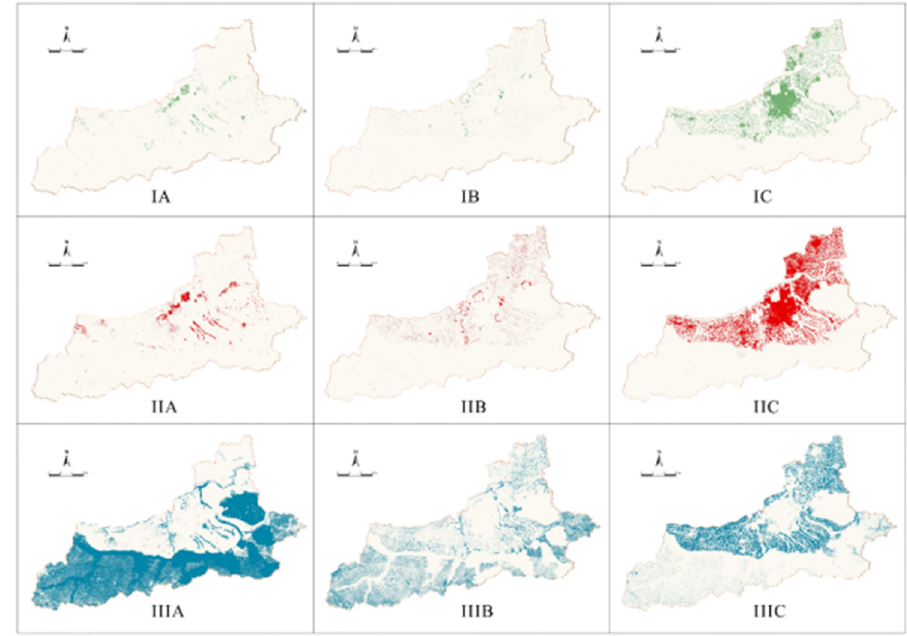
Figure 9. Modes of spatial control zoning. (IA-IIC derived from Figure 4).